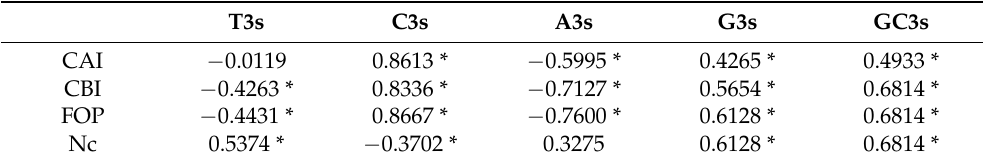
Table 4. Correlation analysis of codon usage indices in